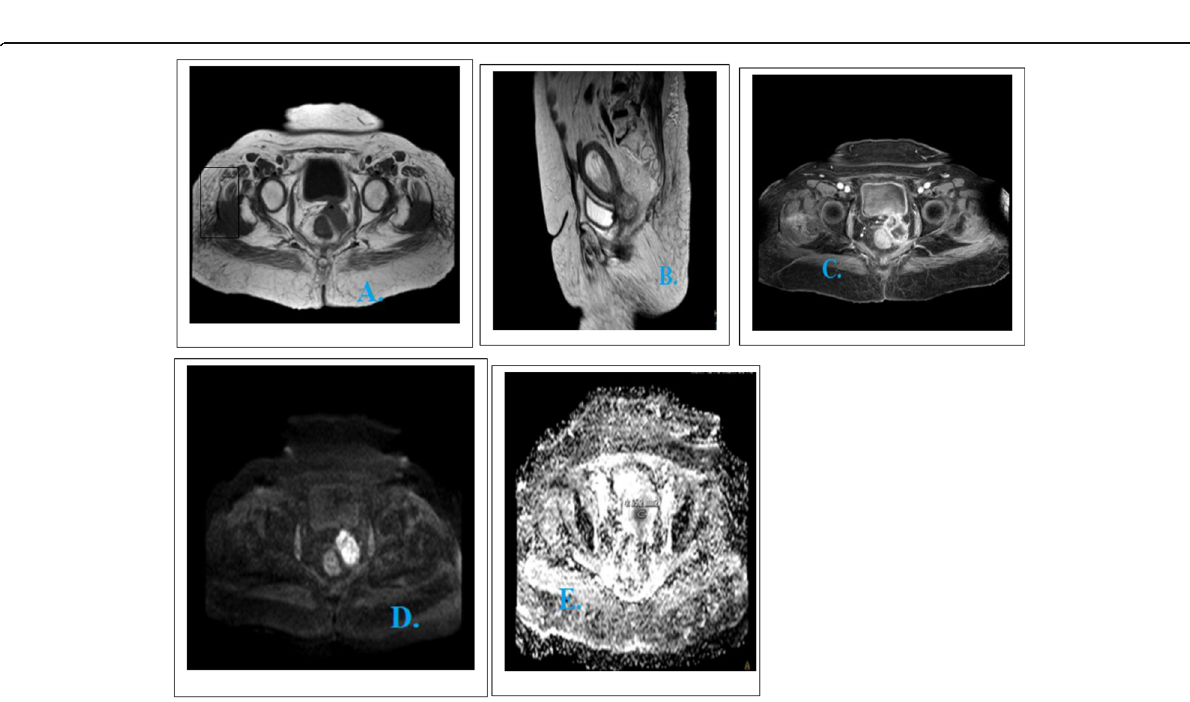
Fig. 5 Forty-five-year-old female patient presenting with irregular vaginal bleeding. a – c Axial T1WI, sagittal T2WI, and post-contrast axial image revealed the presence of ill-defined heterogeneously enhancing exophytic soft tissue mass lesion centered upon and infiltrating the cervix measuring 6 × 4 × 4.7 cm in (AP, transverse, CC) dimensions. It is also seen inseparable from the left posterior urinary bladder wall with smudging of surrounding fat planes. It elicits isointense signal on T1 and hyper intense signal on T2. High signal on DWI ( d ) and low signal on the corresponding ADC maps ( e ). ADC value was 0.644 × 10 − 3 mm 2 /s. Finding suggestive of malignant lesion. Pathology revealed non-keratinizing squamous cell